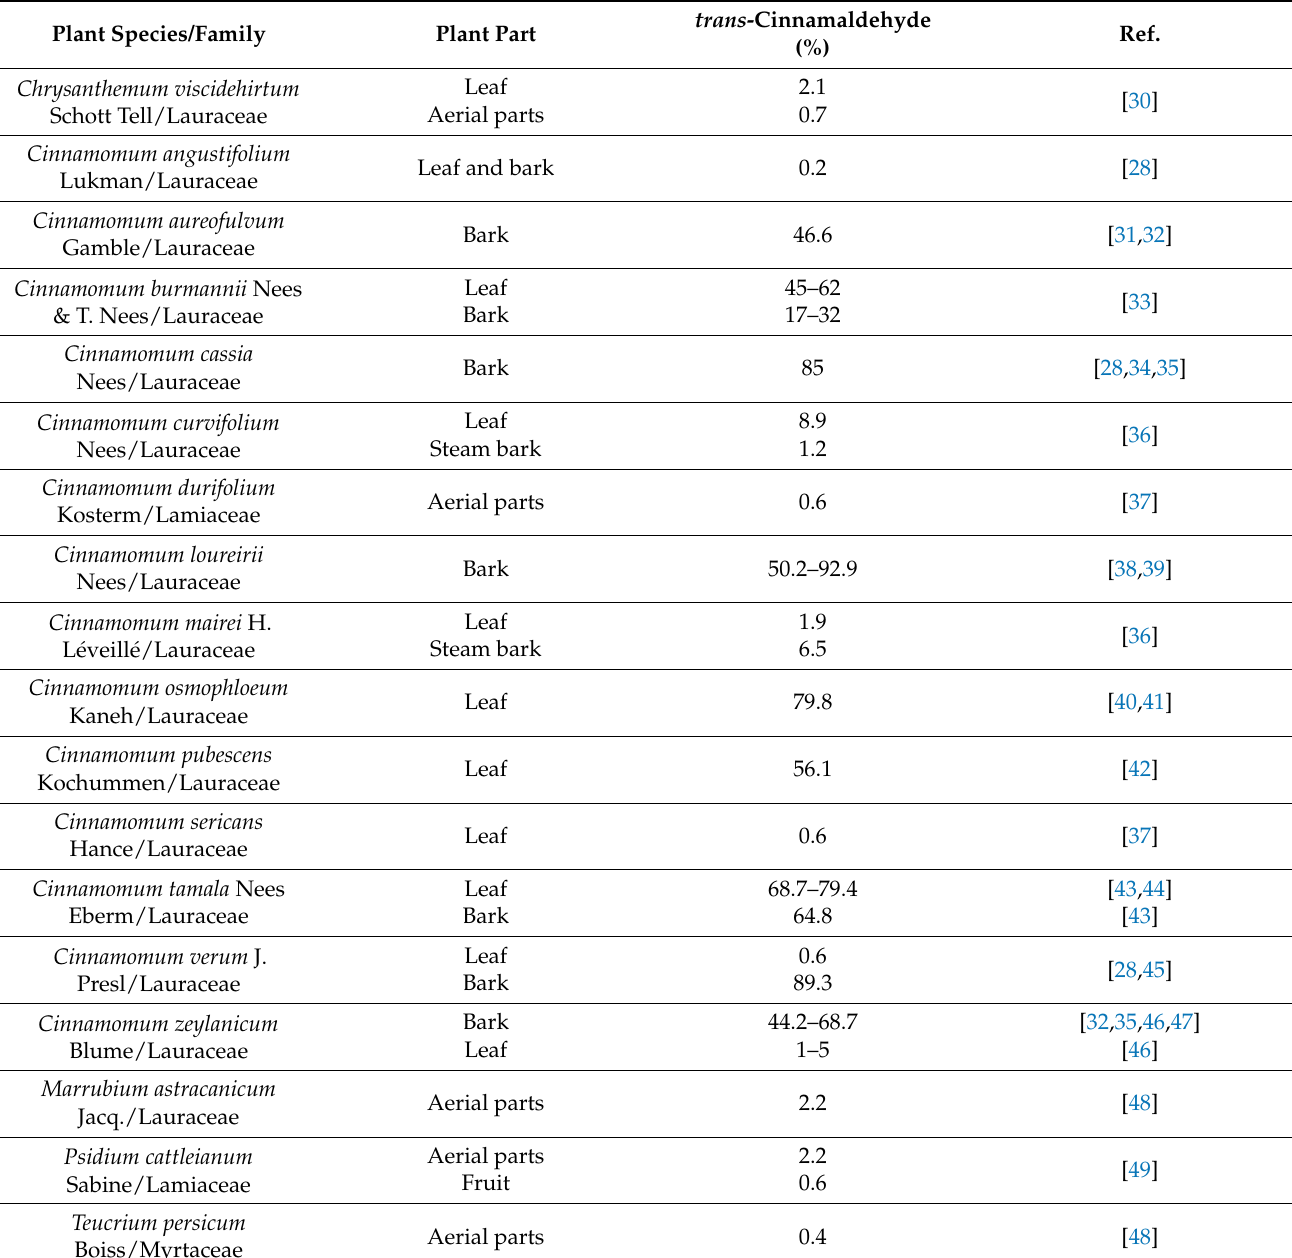
Table 1. Natural occurrence of trans -cinnamaldehyde in plant essential